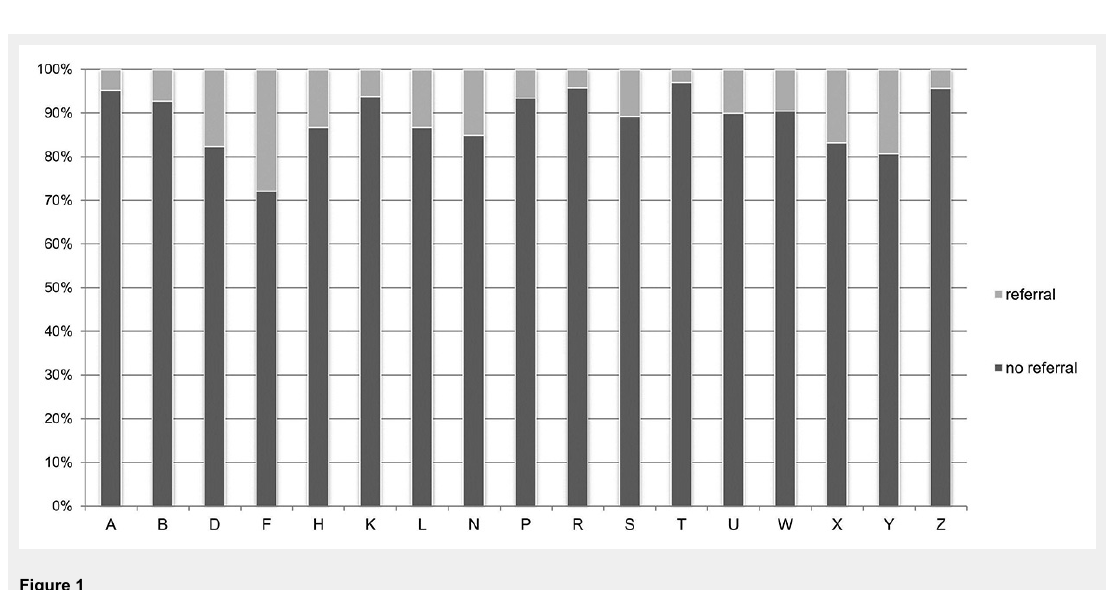
Referral rates according to ICPC-2 chapters. Percentage of reasons for encounter (RFE) according to ICPC-2 chapters which led to a referral (light) or were handled in primary care (dark). (A General and unspecified; B Blood, blood forming organs, lymphatic, spleen; D Digestive; F Eye; H Ear; K Circulatory; L Musculoskeletal; N Neurological; P Psychological; R Respiratory; S Skin; T Endocrine, metabolic and nutritional; U Urology; W Pregnancy, childbirth, family